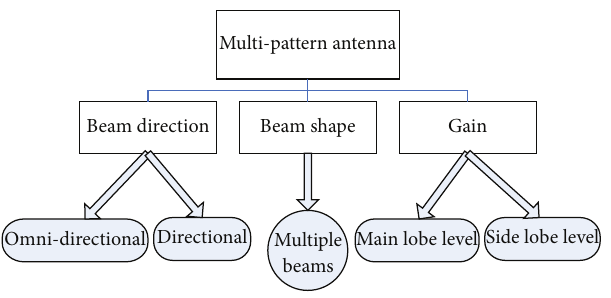
Figure 1: Classification of multipattern antennas.